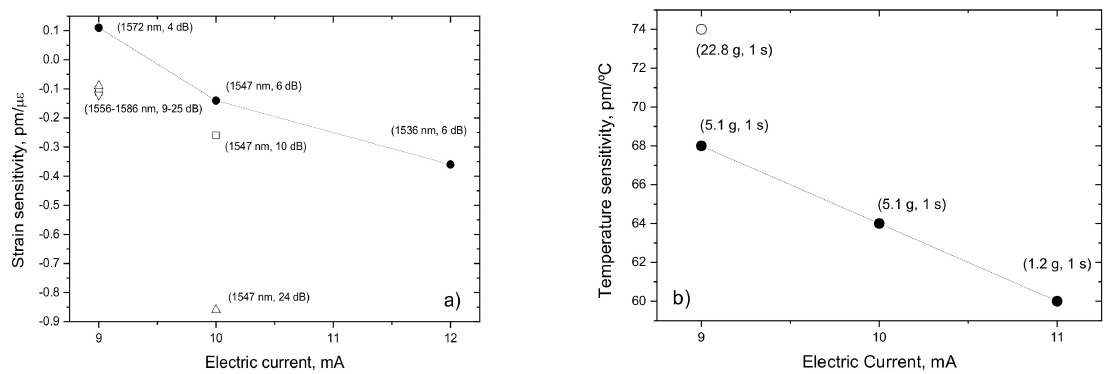
Figure 13. ( a ) Strain and ( b ) temperature sensitivity of LP 14 for different values of electric current and external pulling tension. Reprinted with permission from ref. [103]. © 2021